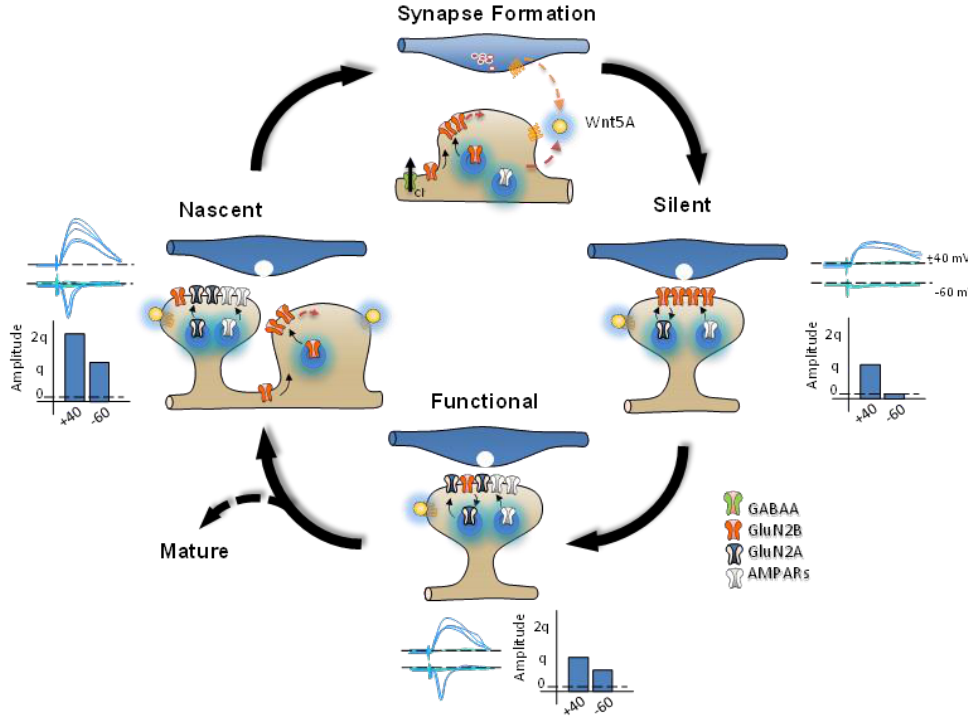
Figure 2. The endowment of glutamatergic receptors and functional changes during developmental plasticity. Synapse formation: GABA A receptor-mediated depolarization may contribute to the re- lease of Wnts from neurons; these Wnts can then act both pre- and postsynaptically to induce syn- synapses show both successes (dark blue) and failures (light blue) of synaptic transmission.